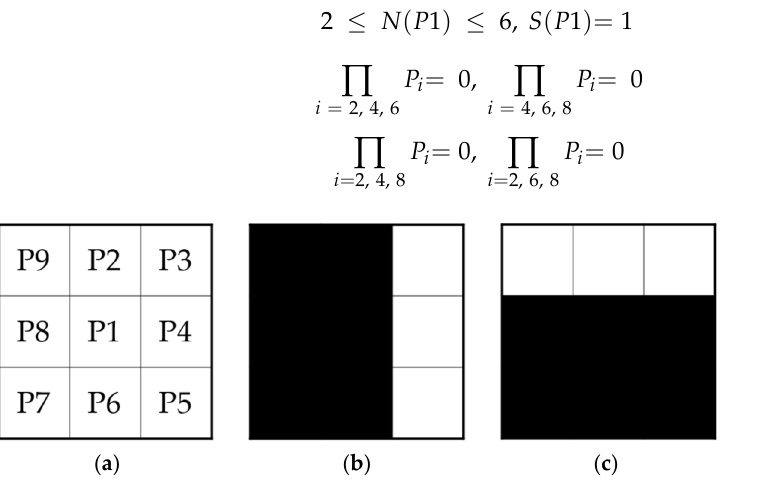
Figure 6. Pixel diagram: ( a ) 3 × 3 pixel window; ( b ) pixel window satisfying the first traversal; ( c ) pixel window satisfying the second traversal.